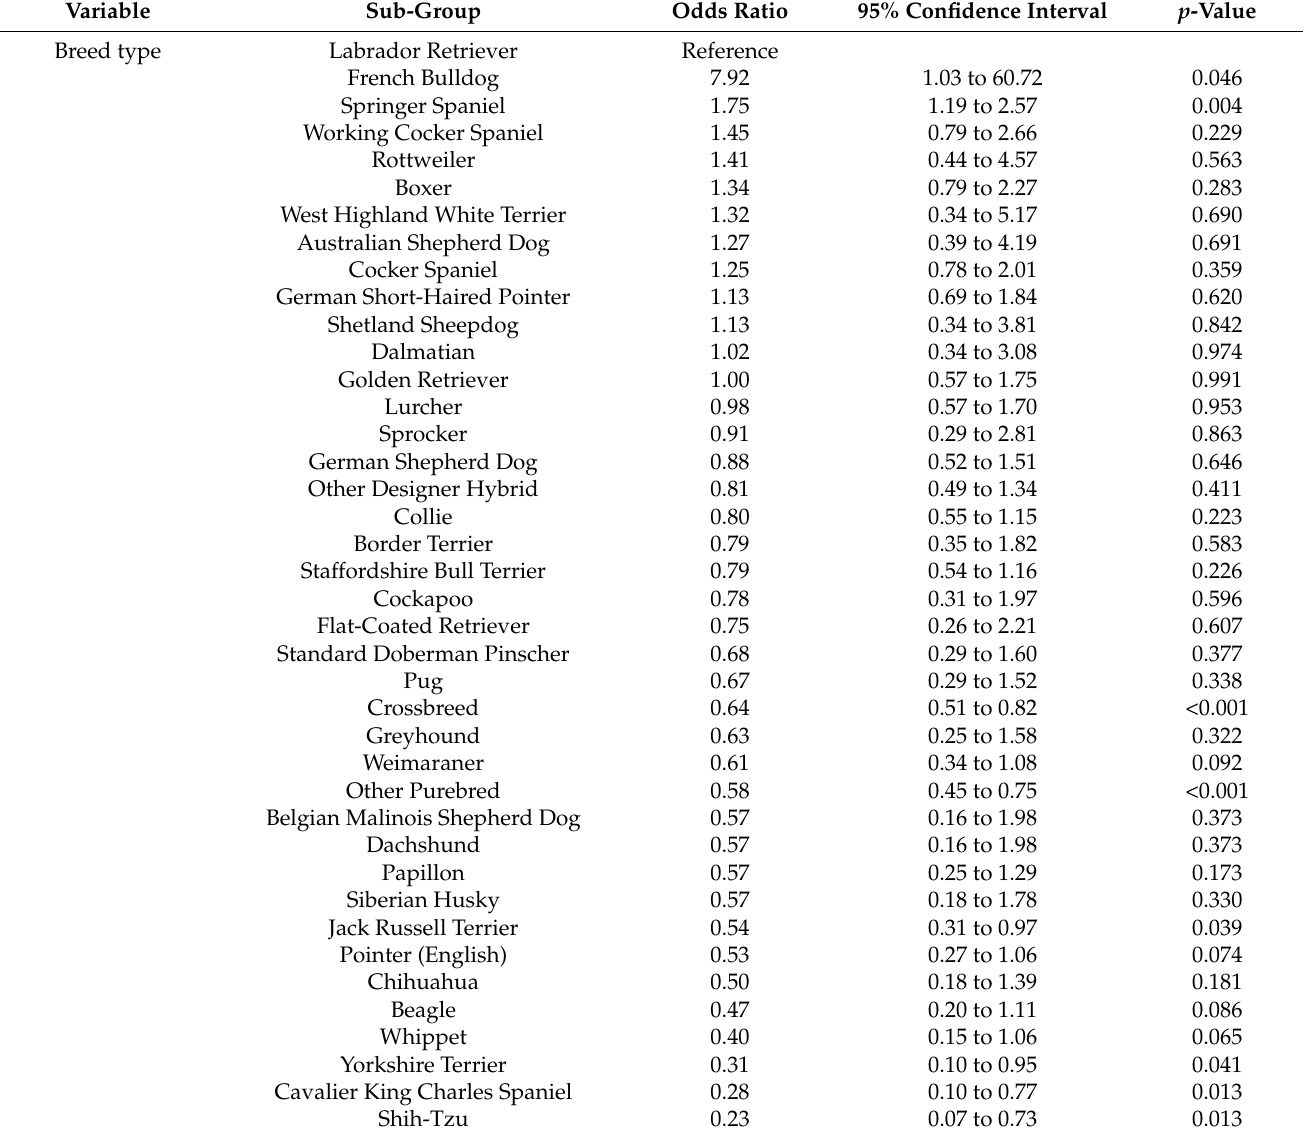
Table A4. Univariable logistic regression results for breed type associated with post exercise cooling in summer. Increased odds of coat use are indicated by an odds ratio greater than one, an odds ratio lower than one indicates reduced odds of coat